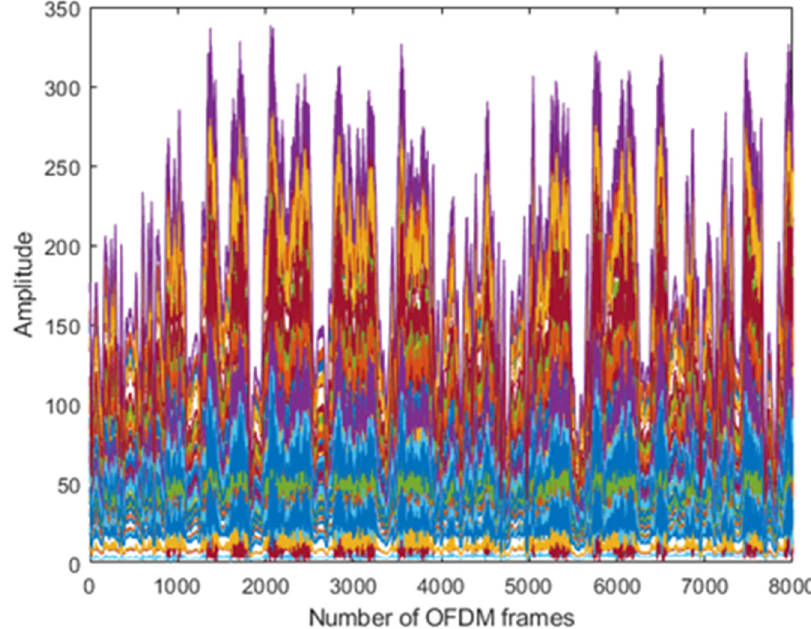
Figure 5. WCSI amplitude response of running activity experiment.